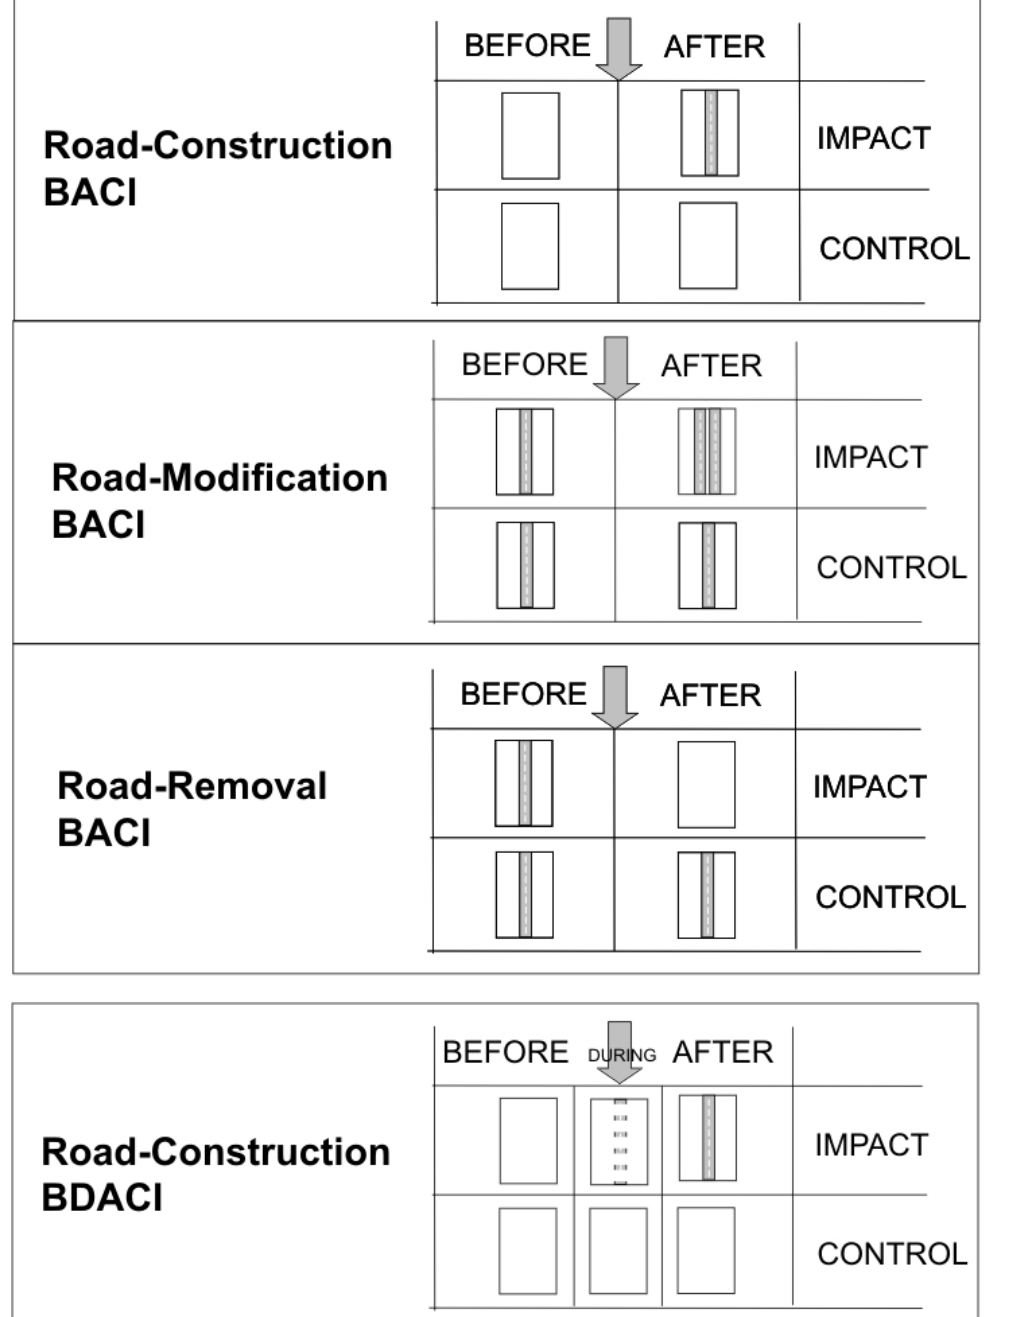
Fig. 2 . Three types of road before-after-control-impact (BACI) study designs. An elaboration of the road-construction BACI is the BDACI design (before-during-after-control-impact), in which effects may be evaluated during the road construction